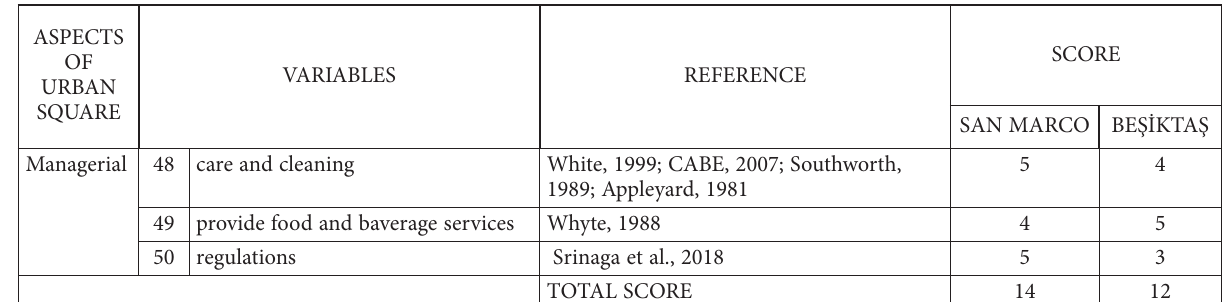
Table 6. Managerial quality parameters